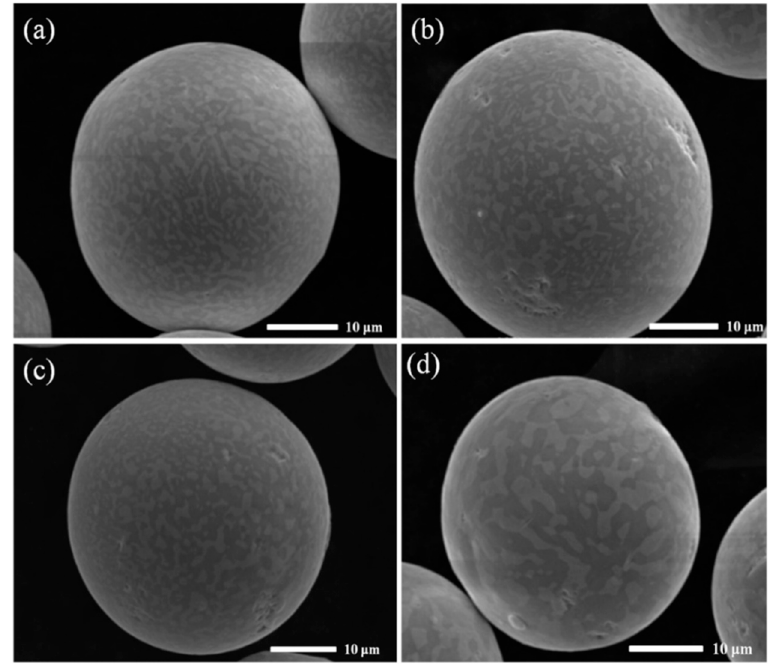
Figure 3. Scanning electron microscopy (SEM) images of rapidly solidified eutectic Sn–Pb37 powder after aging for ( a ) 7, ( b ) 21, ( c ) 29, and ( d ) 40 days.